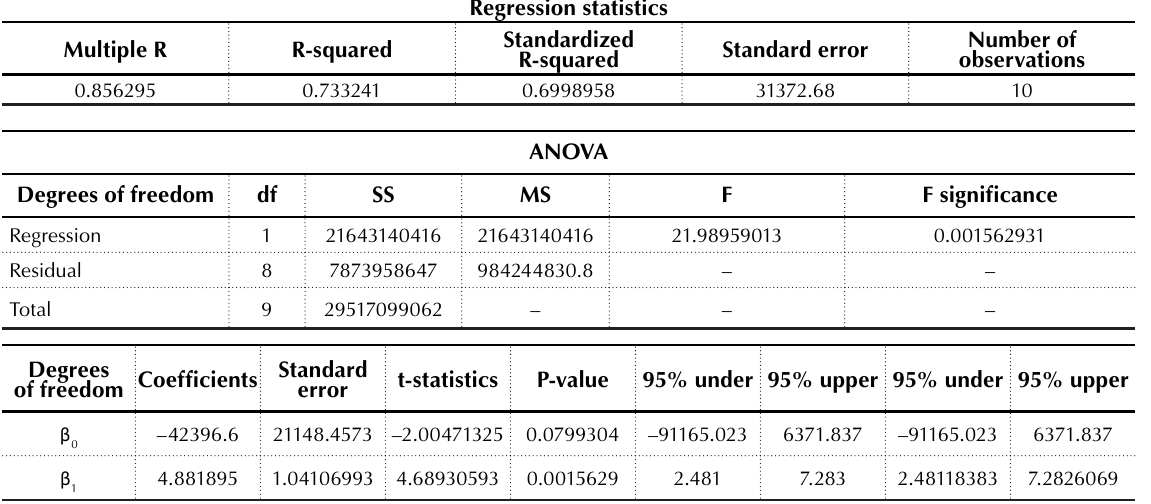
Table 7. Regression analysis results of the relationship between the marketing costs and the profit margin of agricultural enterprises in Khrystynivka district, Cherkasy region (according to 2007–2016